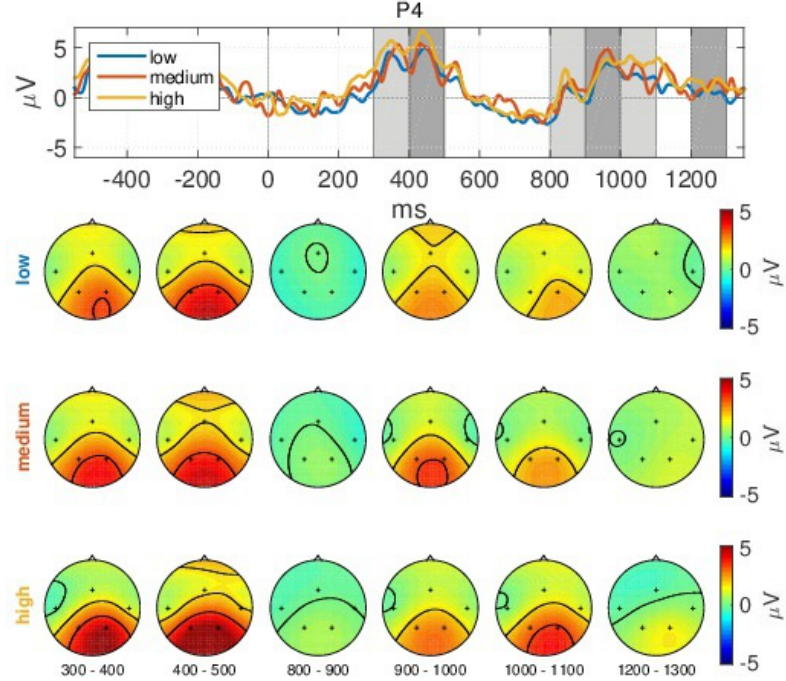
Figure 12. GA ERP for Frac images on three complexity levels according to CFD. GA ERP temporal evolution at channel P4 (top plot) and GA ERP spatial evolution at different timings (bottom scalp plots). Spectral Activity vs. Participants